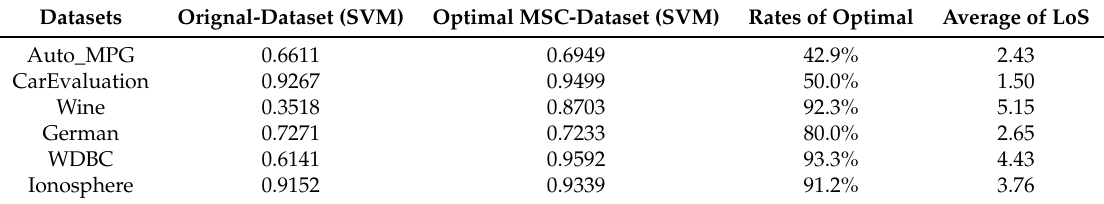
Table 7. Experiments results of Algorithm